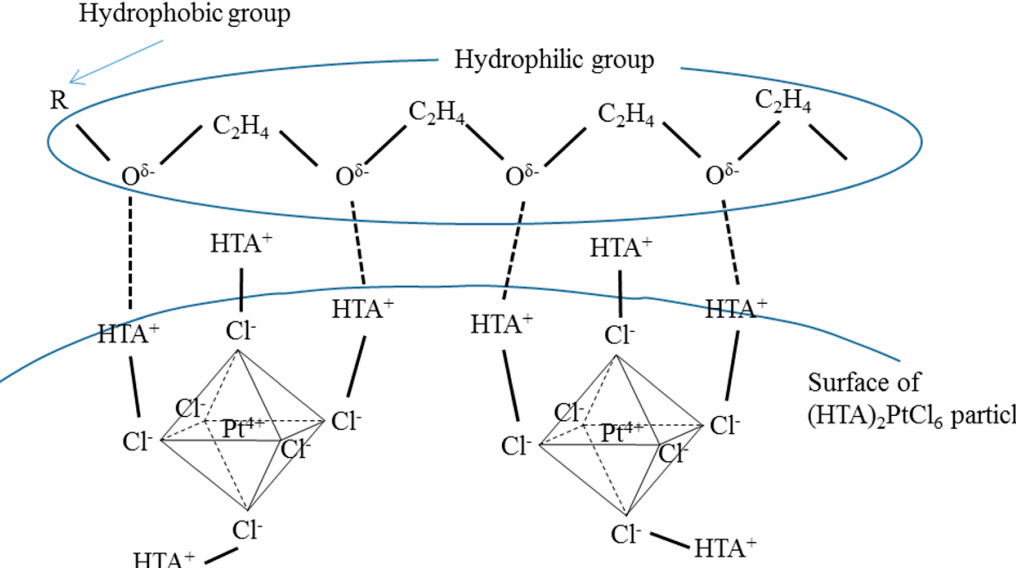
Figure 2. Stabilization of Pt particles by